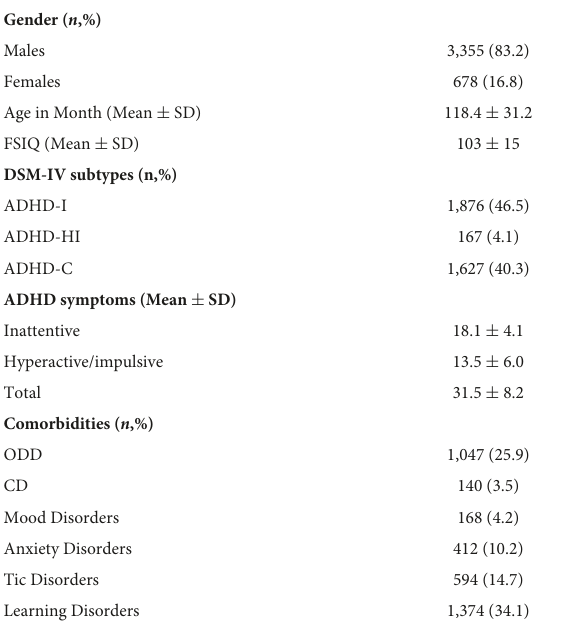
TABLE 1 The demographic and clinical characteristics of children with